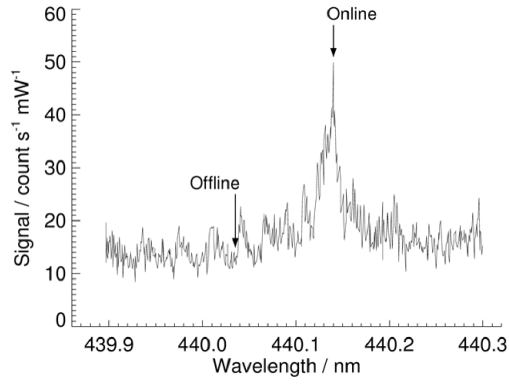
(cid:16) (cid:17) 8 1 spectrum of Figure 3. Laser-induced phosphorescence 0 ∼ 8 × 10 9 molec.cm − 3 glyoxal at a cell pressure of 100 Torr ( ∼ 13300Pa), showing the online and offline wavelengths used for ambient glyoxal measurements. All background signals have been removed from the data, with the signal thus representing glyoxal laser-induced phosphorescence for all wavelengths shown. Each data point was integrated over 1s (5000 laser pulses). The wave- length increment between adjacent data points is